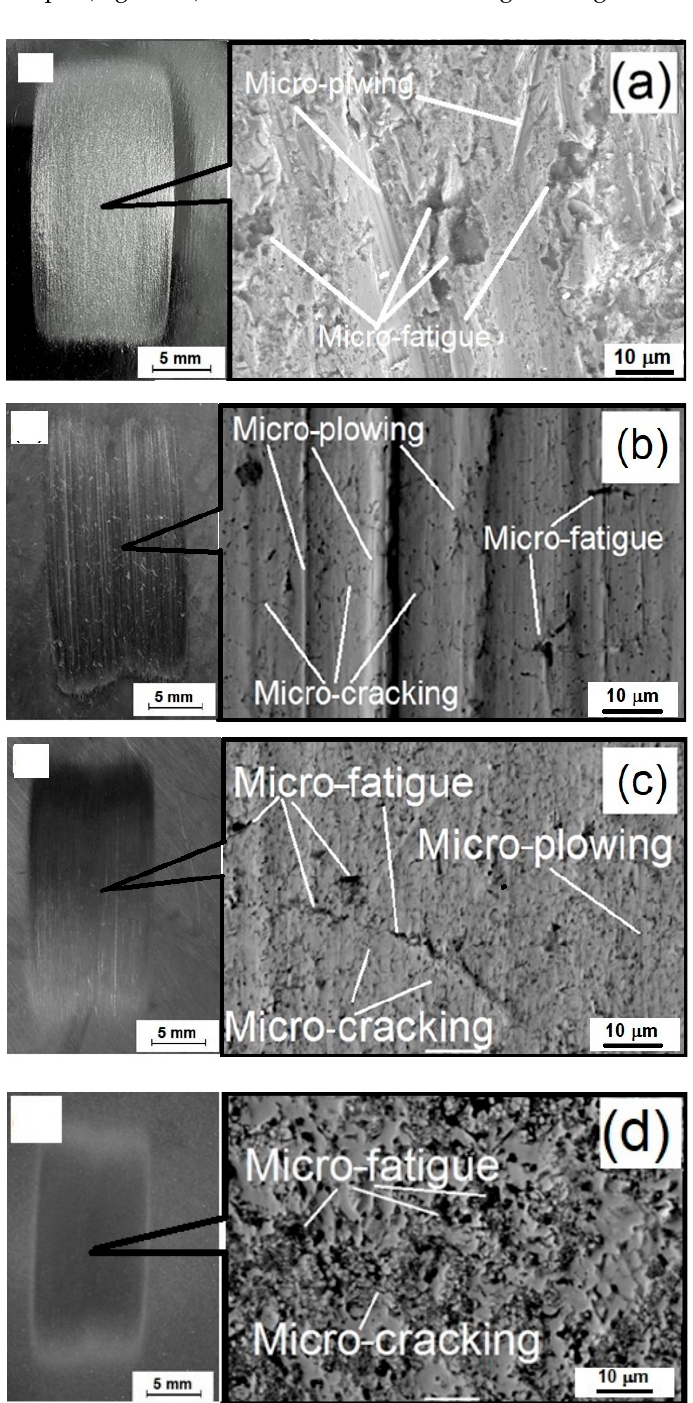
Figure 4. Wear tracks at the surface of the ( a ) untreated sample, and ( b – d ) samples exposed to car- burizing, nitriding and boriding processes, respectively. carburizing, nitriding and boriding processes,